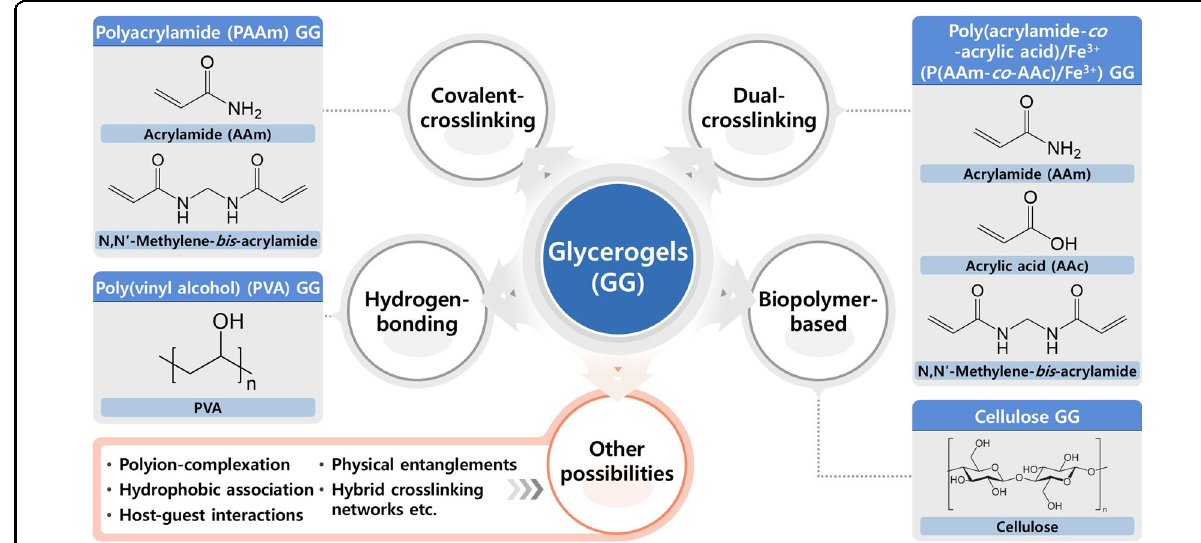
Fig. 2 Different monomers/polymers and crosslinkers used for designing GGs. Method versatility facilitates the design of numerous multifunctional